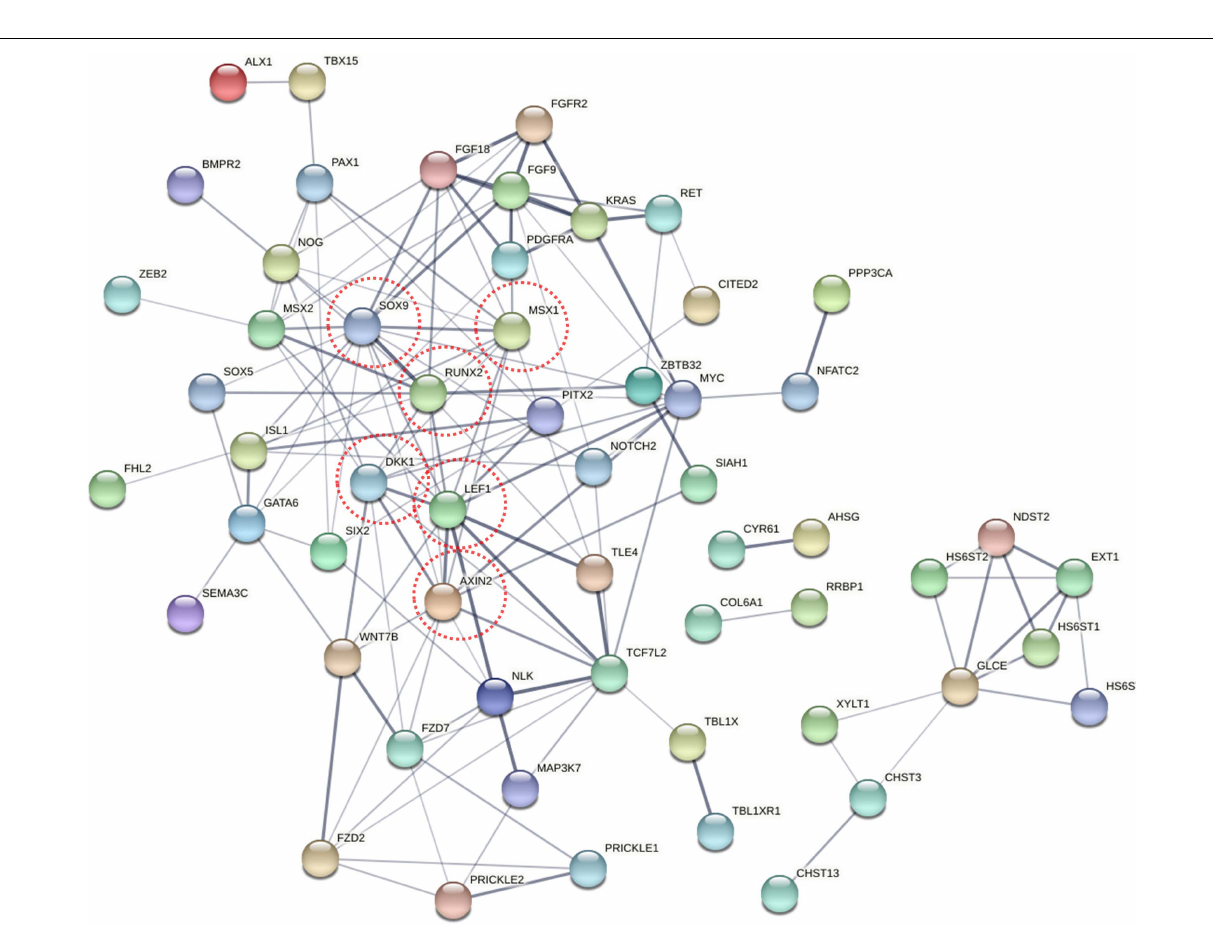
FIGURE 6 | The network of 76 different methylated genes (DMGs) from KEGG pathway and GO terms on CG context. Analysis of the interaction uses STRING software according to the interplay index (confidence > 0.4). The interplay index between genes was represented by edge width and transparency. Dark and wide edges indicated high